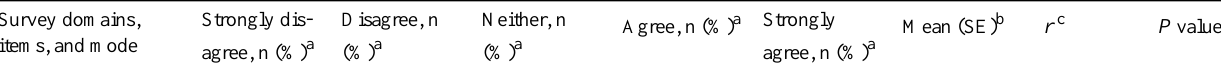
Table 2. Summary of responses by those who participated in telehealth, characterizing their telehealth (n=106) and in-person (n=96) experiences.